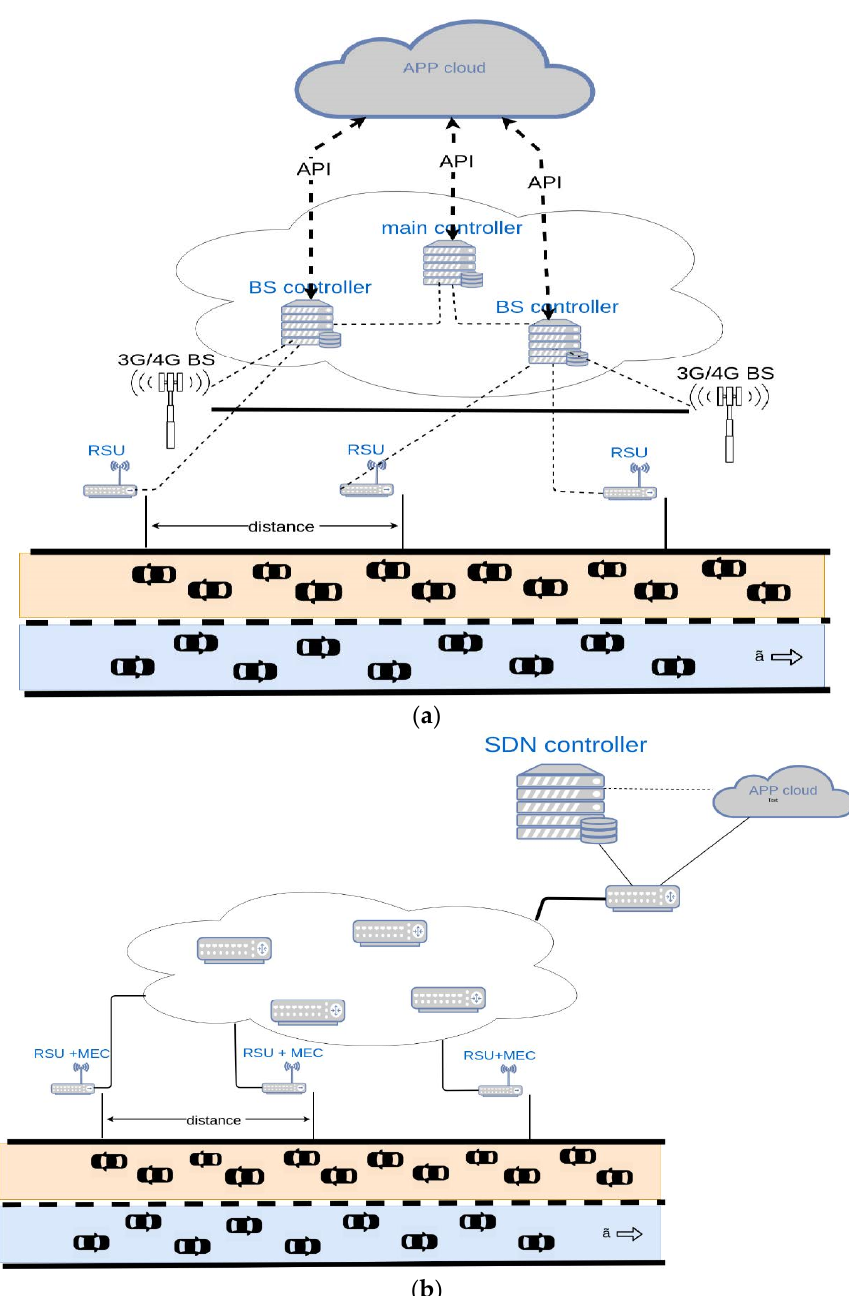
Figure 1. ( a ) General structure of the traditional vehicular ad-hoc network (VANET). ( b ) The end-to-end system structure of the proposed novel VANET system.